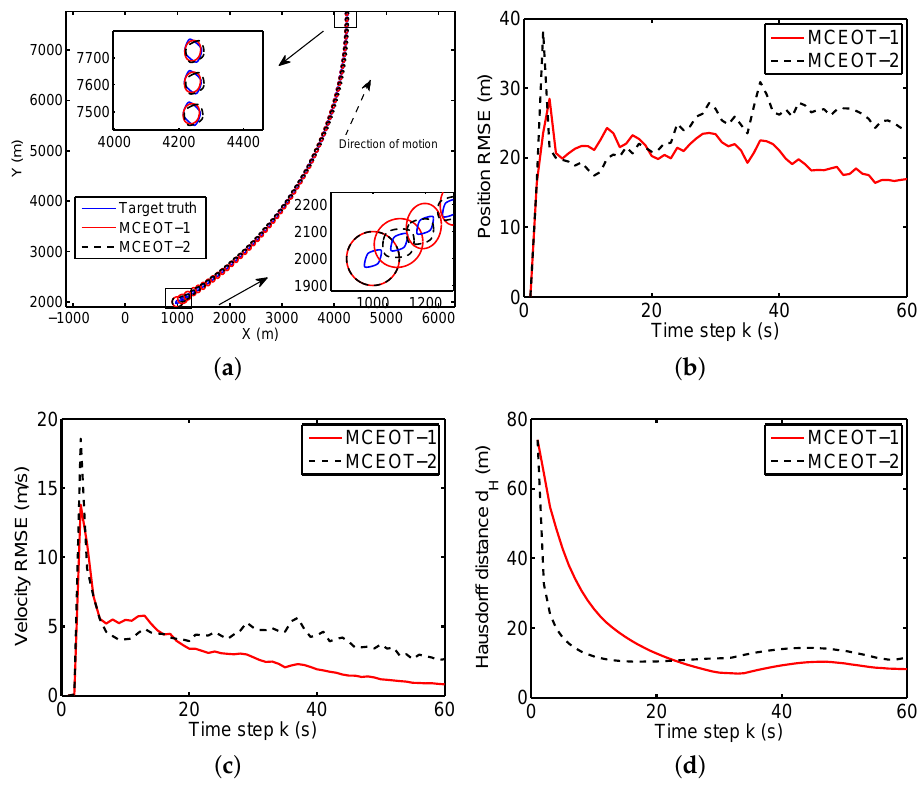
Figure 7. Simulation results in scenario C. ( a ) the object trajectory; ( b ) position RMSE; ( c ) velocity RMSE; ( d ) Hausdorff